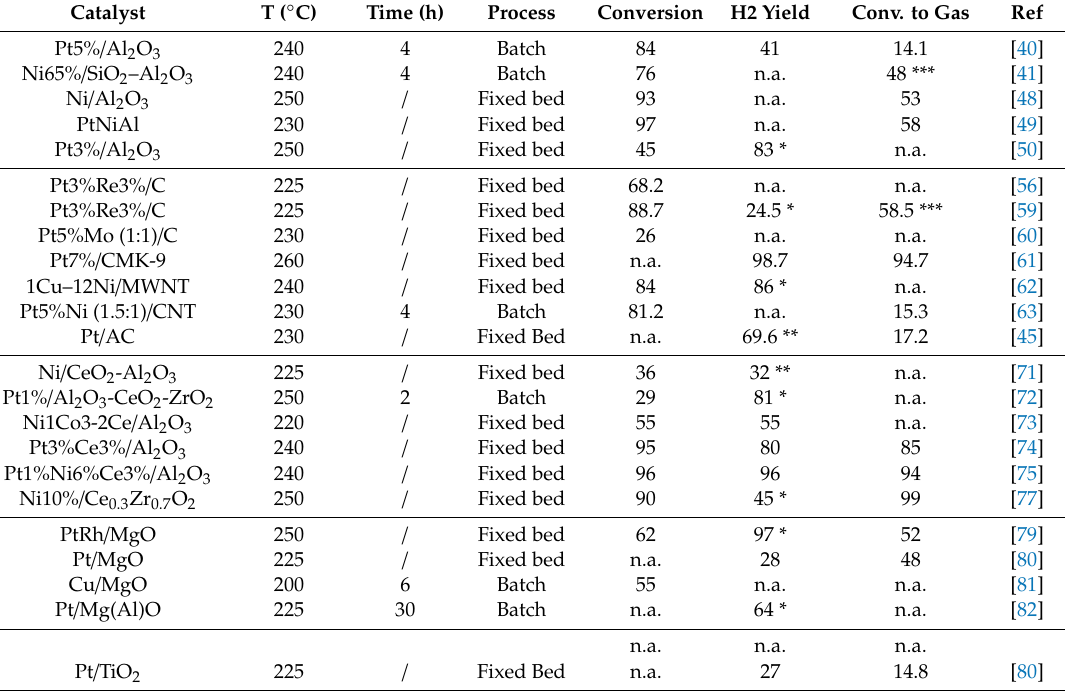
Table 1. APR results in terms of glycerol conversion, hydrogen yield, and carbon conversion to gas shown for di ff erent supported metal-based